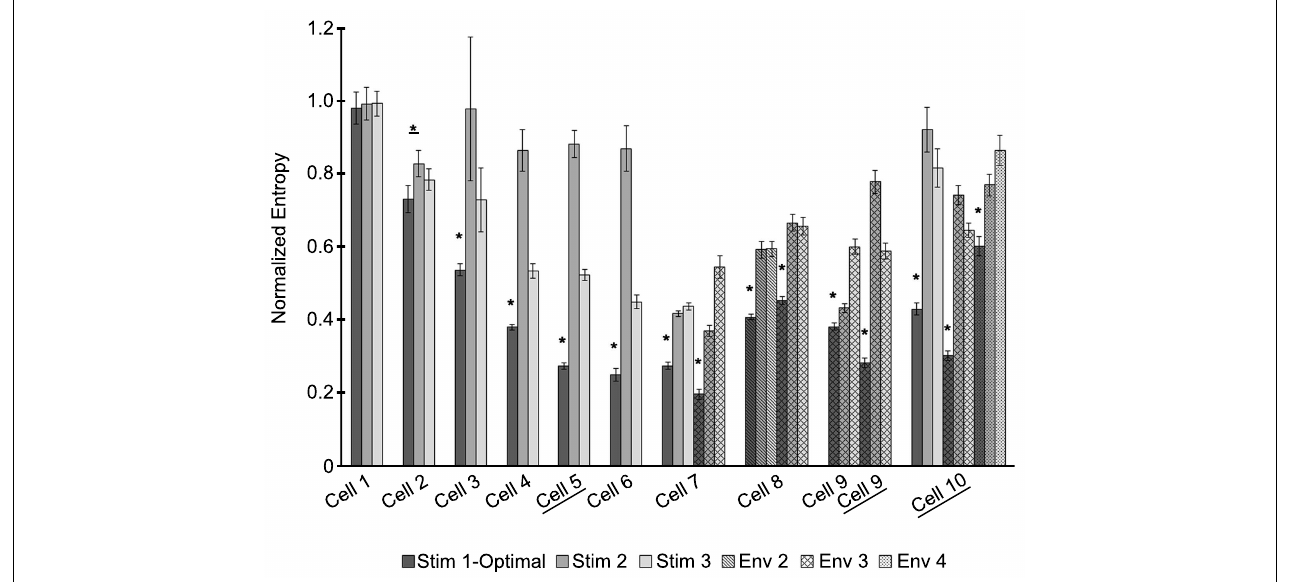
FIGURE 5 | The optimal stimulus waveform is significantly better at entraining neurons to the stimulus across cells. Entropy values for each stimulus applied are shown for 10 cells. Some cells had stimuli from more than one envelope applied. Envelopes are indicated by different patterns, with envelope 1 being the solid fill. For each envelope, three stimuli were